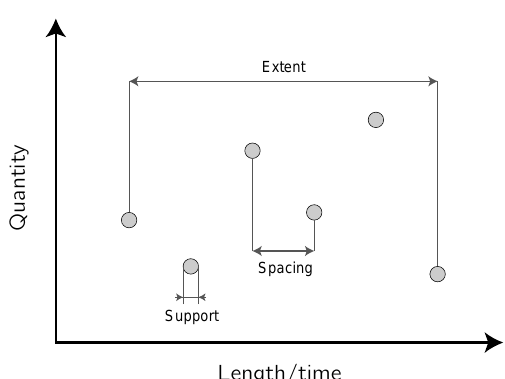
Figure 3. Illustration of the observation scale of a set of measure- ments (based on Blöschl and Sivapalan, 1995). Support is the inte- gration volume or time of a single sample, spacing is the distance or time between individual samples, and extent is the total coverage in space or time of the entire data set.